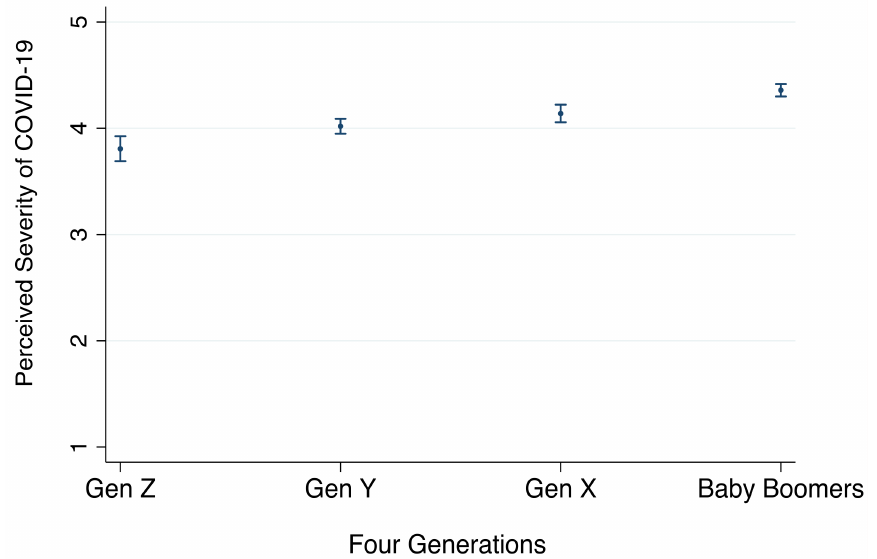
Figure 1. Comparison of Perceived Severity of COVID-19 by four generations, with 95% CI. Note: Perceived severity is measured as an average of three items, on a 5-point scale with bigger values indicating higher levels of perceived severity (see details in Table